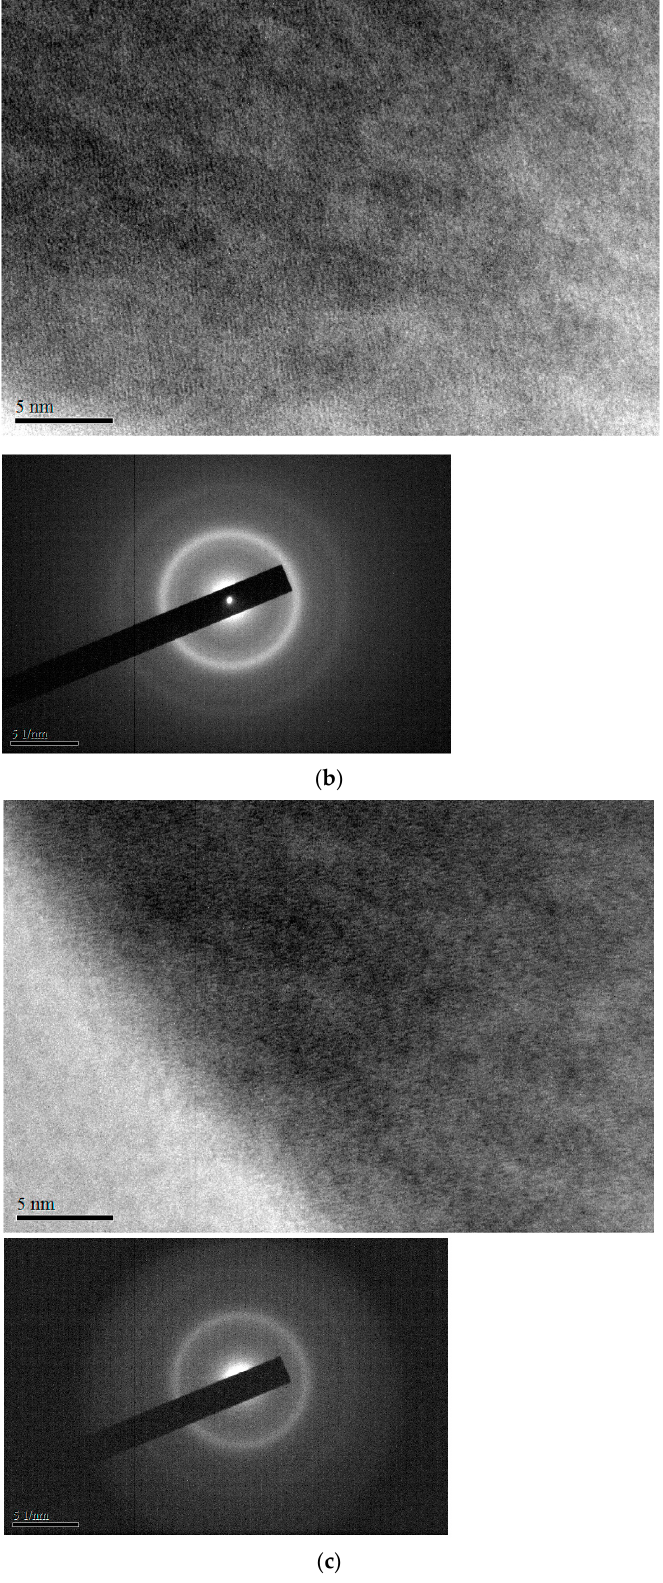
Figure 4. ( a ) Transmission electron microscopy (TEM) micrograph and electron diffraction pattern of as-plated Fe-Cr-C alloy deposit prepared at 20 ASD; ( b ) TEM micrograph and electron diffraction pattern of as-plated Cr-Fe-C alloy deposit prepared at 25 ASD; ( c ) TEM micrograph and electron diffraction pattern of as-plated Cr-Fe-C alloy deposit prepared at 30